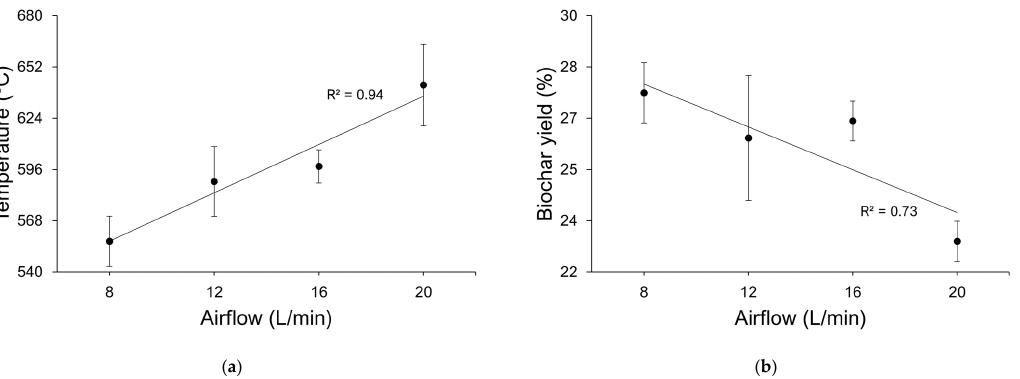
Figure 2. Airflow effect on: ( a ) gasification maximum temperatures; ( b ) wild sugarcane biochar yield.